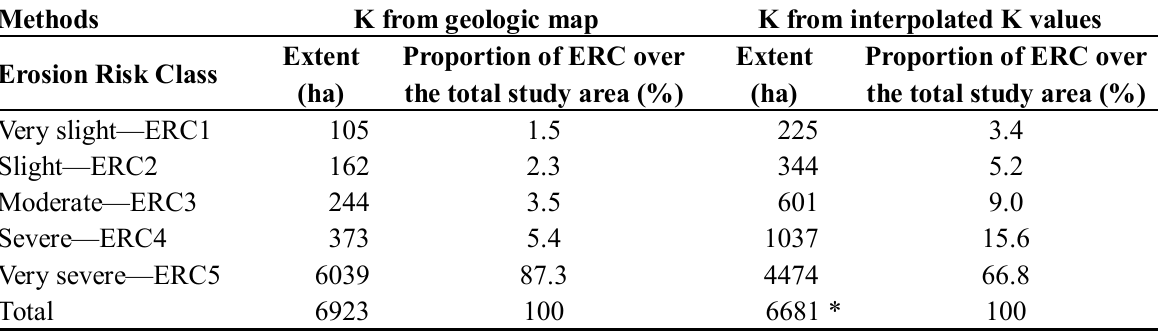
Table 3. Extent of ERCs in the study area.